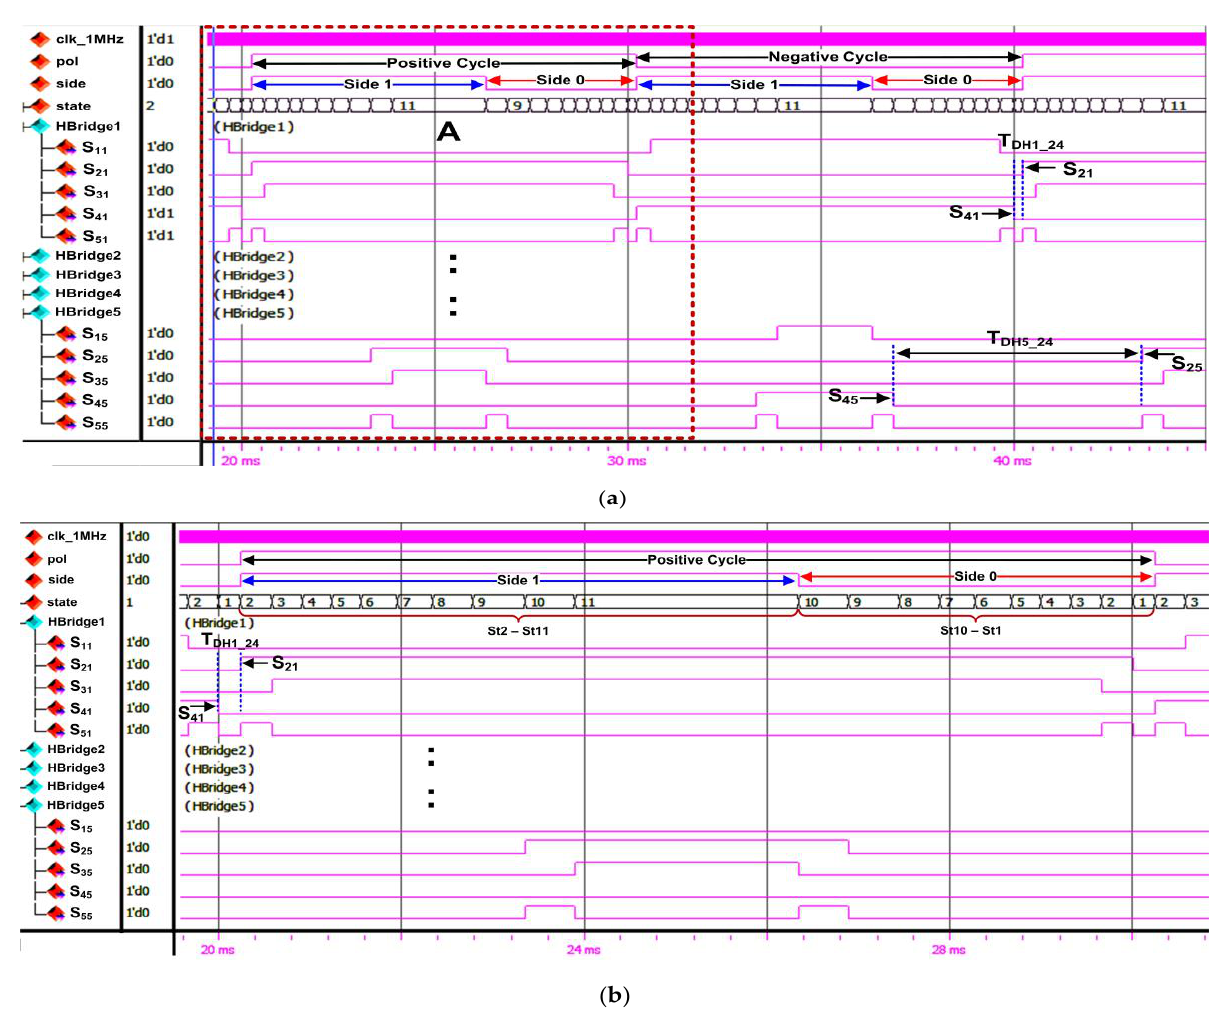
Figure 16. Register transfer-level (RTL) simulation results of the SHE digital switching controller: